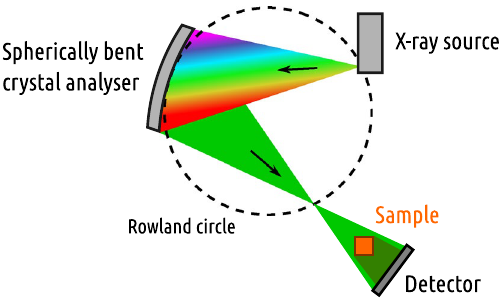
Figure 1. The schematic drawing of the XAS-CT setup. Polychromatic X-rays produced by the X-ray tube are monochromatised with the spherically bent crystal analyser. The sample to be imaged is illuminated by the monochromatised beam by moving it away from the Rowland circle so that the defocused beam covers it completely. The beam transmitted through the sample is recorded with a position-sensitive detector. Lead shielding to reduce scattering from the primary beam to the detector is not shown.